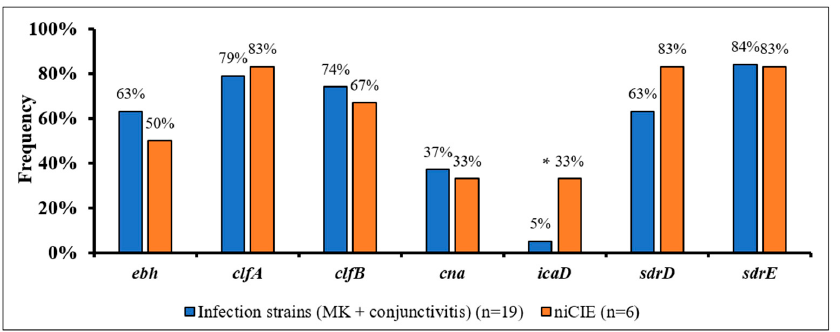
Figure 1. Frequency of seven virulence genes involved in S. aureus adhesion by disease group. *, trend to be more common in niCIE strains ( p = 0.1).